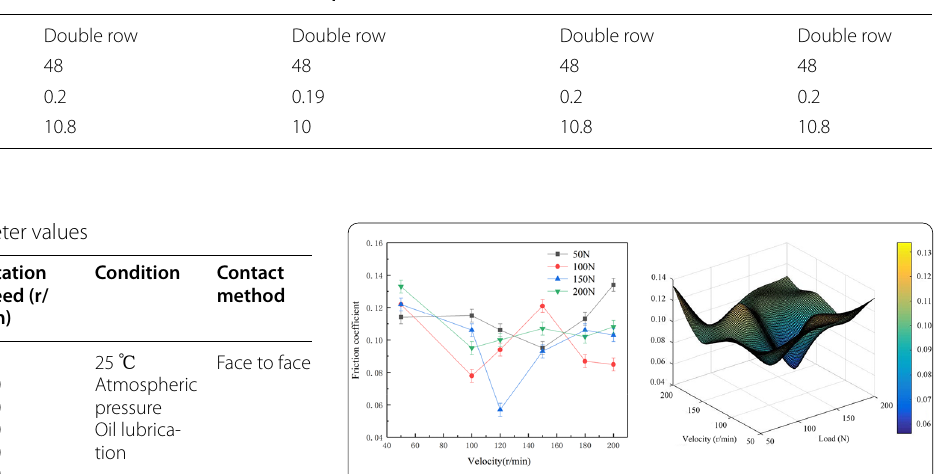
Figure 9 Experimental results of chevron texture